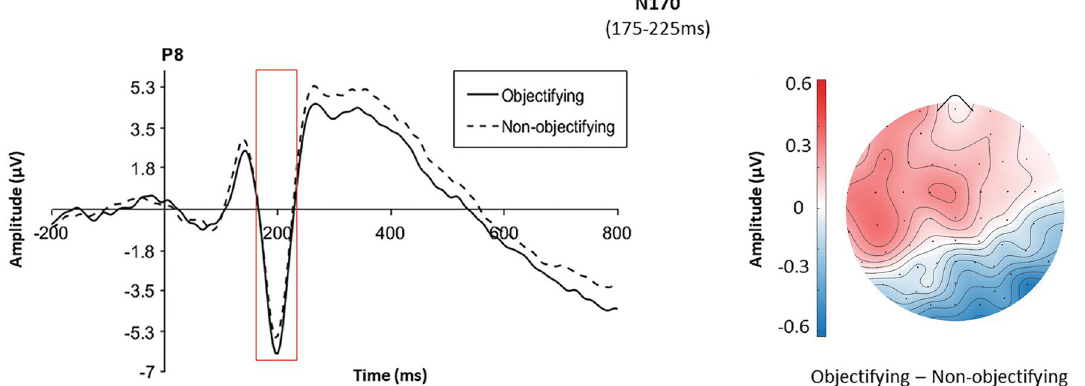
Figure 2. Waveform and scalp distribution of the N170. Waveform (left of the panel) is plotted as a function of the objectification at the right PO8. Scalp distribution (right of the panel) displays the difference between objectifying and non-objectifying condition in the time window 175–225